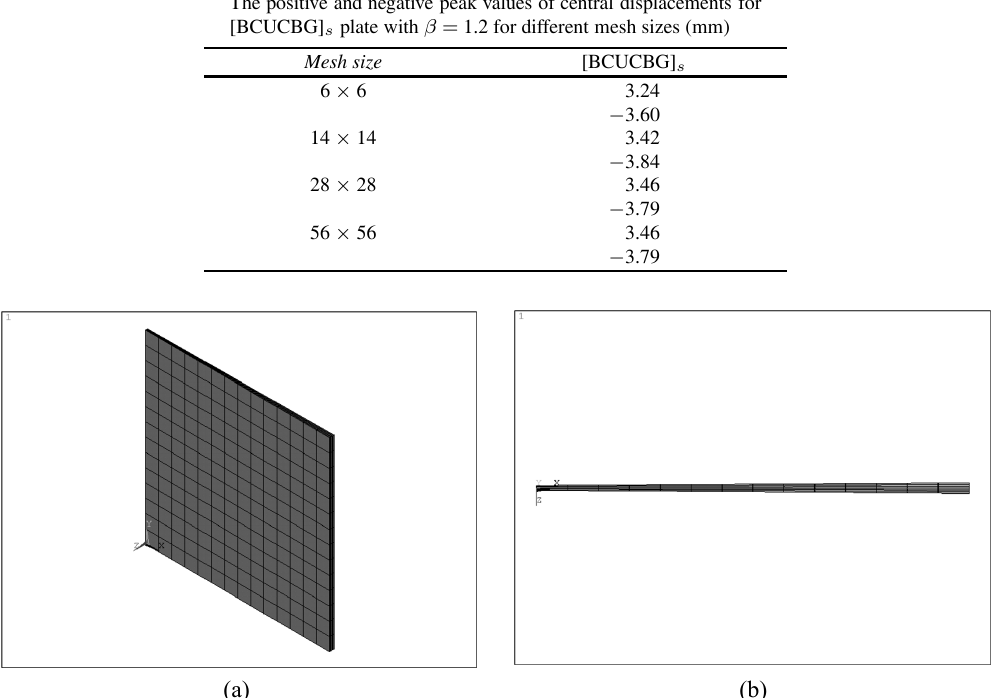
Table 2 The positive and negative peak values of central displacements for